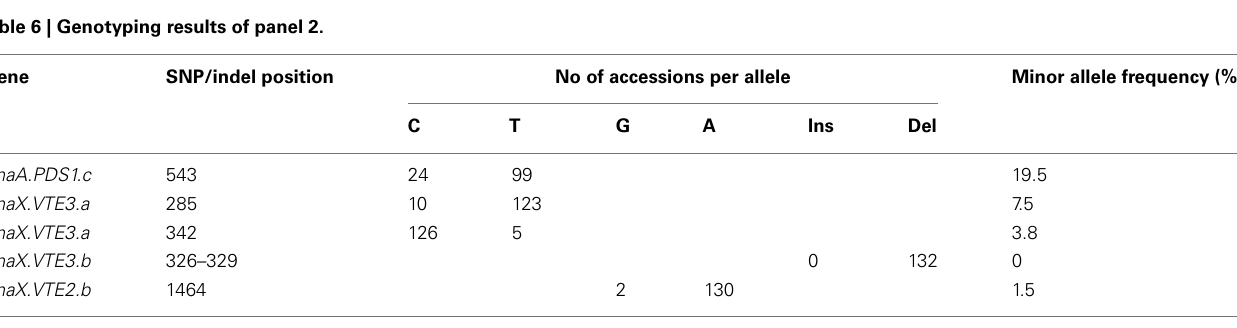
Table 6 | Genotyping results of panel